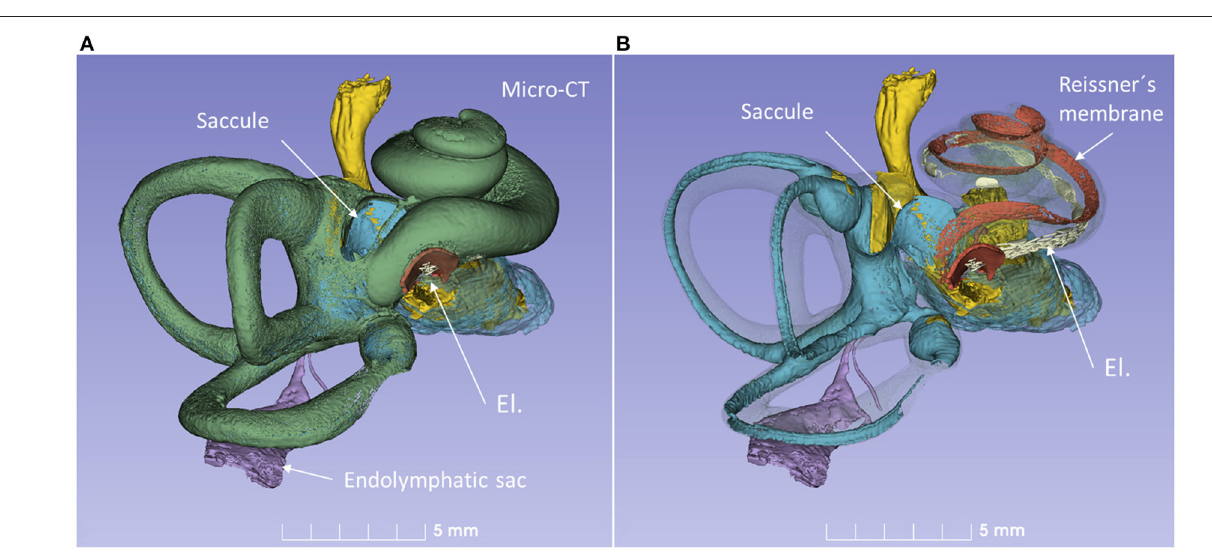
FIGURE 8 | 3D model of a right human temporal bone from micro-CT. Increased penetration time of aqueous I 2 KI improved visualization of soft tissue structures. The cochlea was virtually implanted with an electrode (El) through the RW. (A) With bone capsule. (B) Bone capsule was made transparent to visualize the inner ear soft